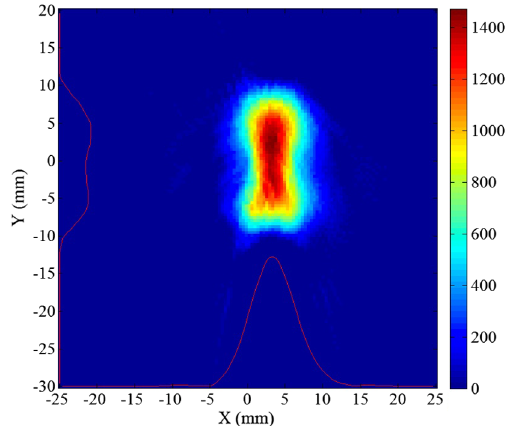
FIG. 14. Reconstructed transverse profiles of the proton beam by the computerized tomography imaging during the normal operation of the CPHS linac, with the beam energy of 3 MeV, repetition frequency of 20 Hz, and beam pulse width of 50 μ